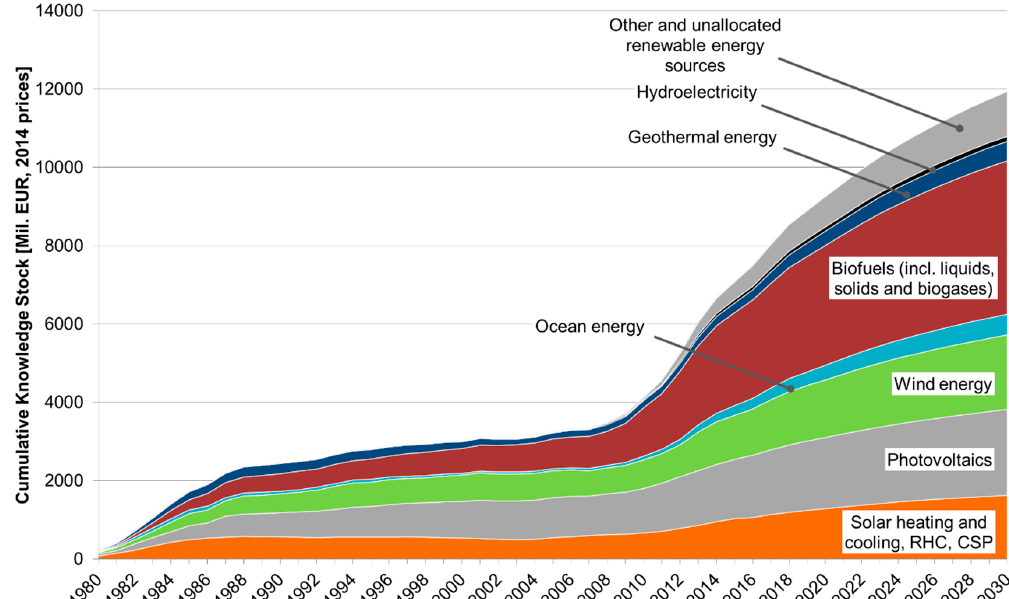
Figure 9. Cumulative RES knowledge stock induced by public R&D expenditures of the EC (Mil. EUR, BAU scenario) (2014 prices and exc. rates; knowledge depreciation, 10%; time lag, three years).